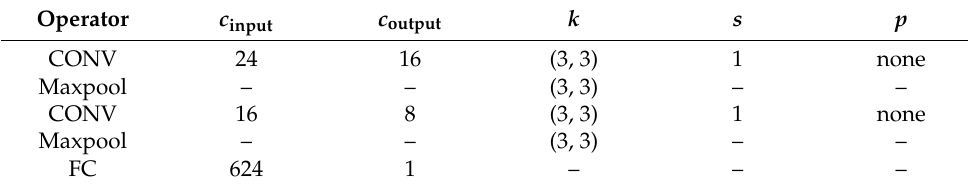
Table 3. SRE specific